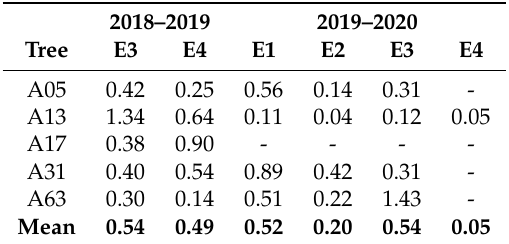
Table 5. Average of the standard deviation obtained from Pp in each tree and stage for the